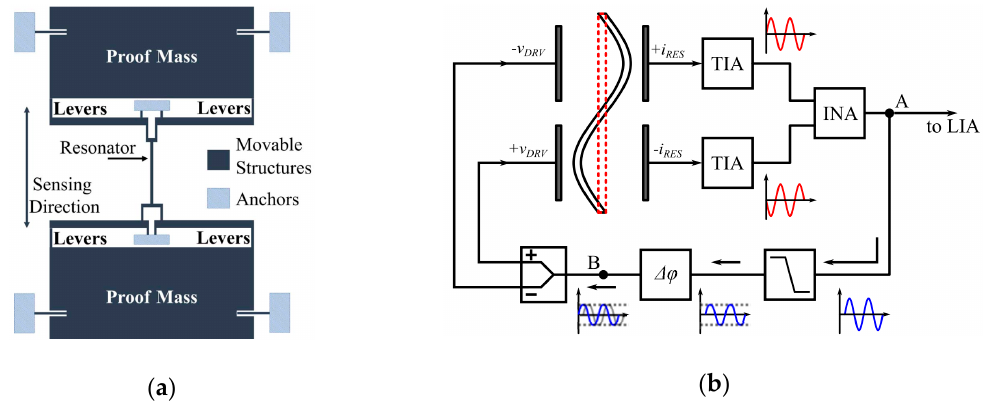
Figure 18. Schematic diagrams of the resonant MEMS accelerometer and the closed-loop circuit developed by Zhao and Seshia et al. at Cambridge University [103]: ( a ) resonant MEMS accelerometer comprising a single DETF; ( b ) closed-loop circuit.